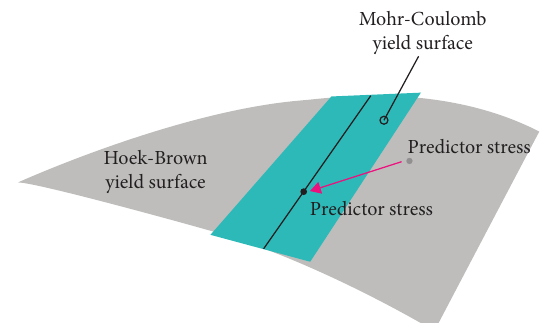
Figure 2: The yield surface of H-B and M-C yield criterion obeying ≥ σ ≥ σ in the principal stress σ 1 2 3